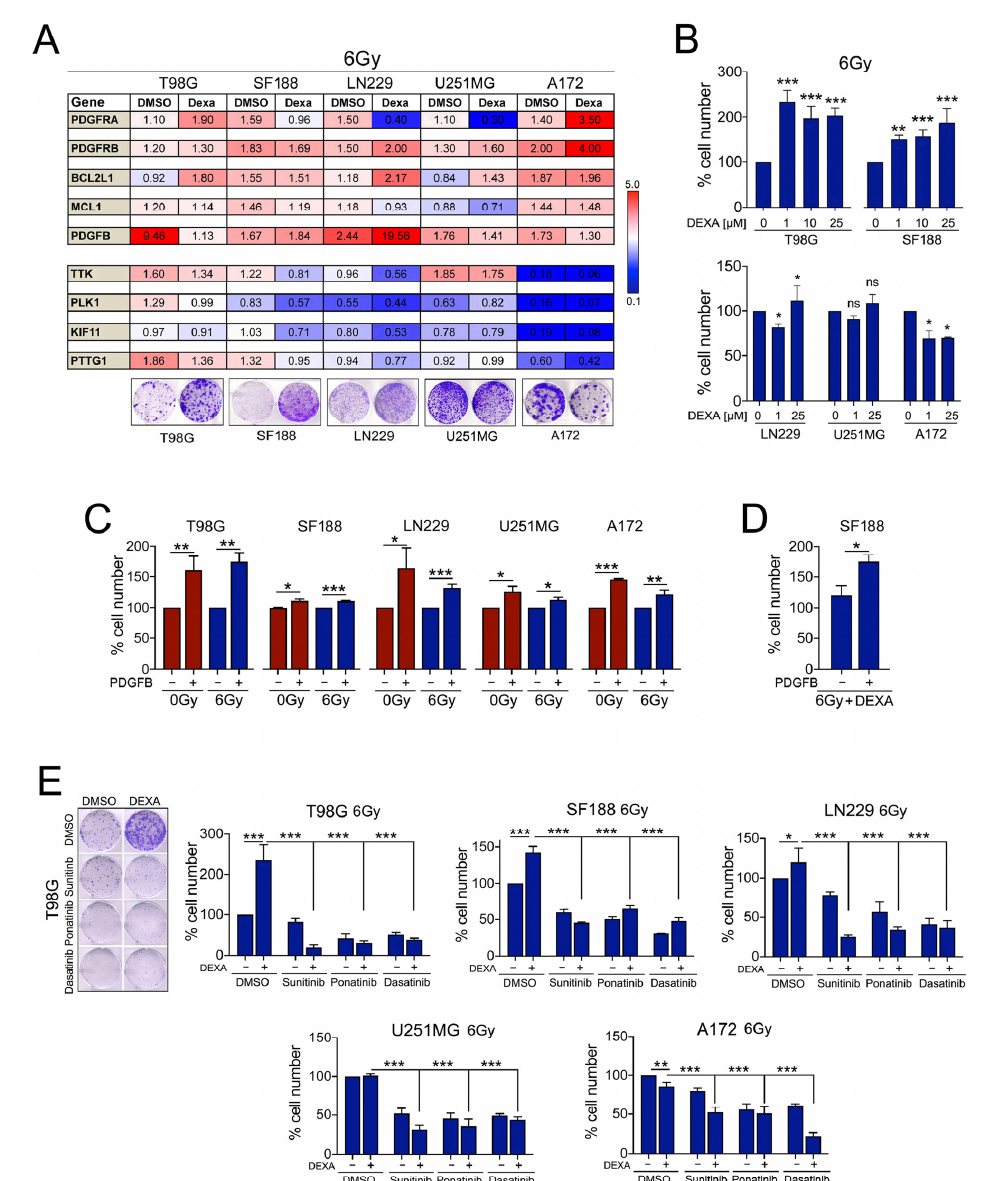
Figure 5. DEXA and PDGFB act as radio-protective factors and tyrosine kinase inhibitors (TKIs) inhibit this protection. ( A ) qRT-PCR analysis for the indicated genes in different GBM cell lines treated with 25 µ M DEXA for 18 h before radiation with 6 Gy. RNA expression was analysed 24 h later. Data are represented as mean fold change of triplicates treated relative to non-radiated DMSO control cells (=1). A colony formation assay is shown as example for the radio-protective effect of DEXA in radiated cells. ( B ) Quantification of cell numbers in the indicated cell lines radiated with 6 Gy in the absence or presence of the indicated concentrations of DEXA as described above. Data represent the mean ± SEM ( n ≥ 3). ( C ) Quantification of cell numbers in the indicated cell lines either non-radiated or radiated with 6 Gy in the absence or presence of recombinant PDGFBB. Data represent the mean ± SEM ( n ≥ 3). ( D ) Quantification of cell numbers of SF188 cells radiated with 6 Gy and treated with DEXA in the absence or presence of recombinant PDGFBB. Data represent the mean ± SEM ( n ≥ 3). ( E ) Quantification of cell numbers in the indicated cell lines radiated with 6 Gy in the absence or presence of DEXA and the indicated inhibitors. Data represent mean ± SEM ( n ≥ 3). * p < 0.05, ** p < 0.01, *** p <